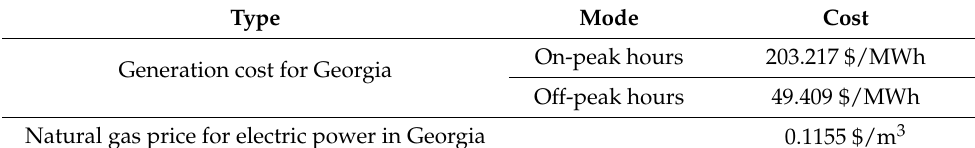
Table 2. Generation costs for metropolitan residential customers’ case study [26,38].